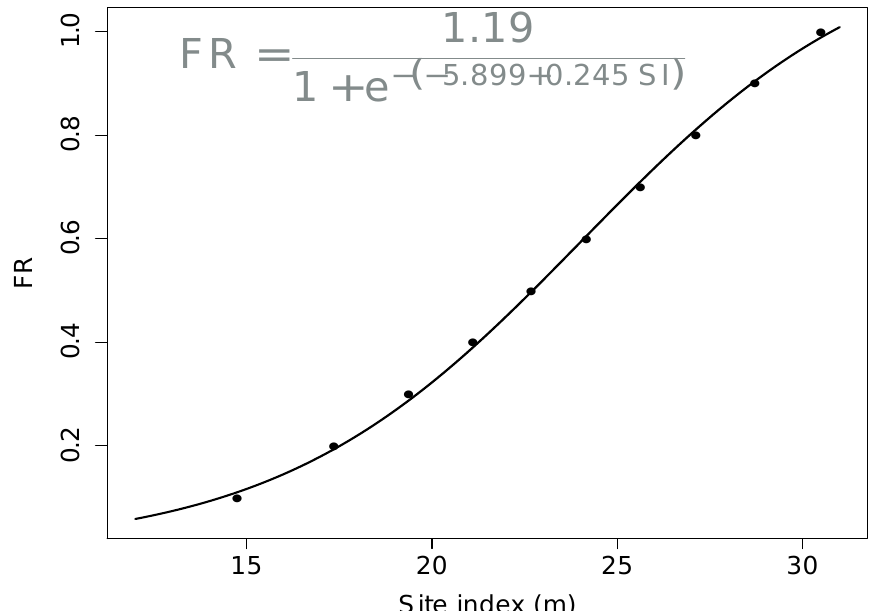
Figure 3. Sigmoidal relationship between Fertility Rating (FR) and site index based on the relationship between stand volume and site index illustrated in Table